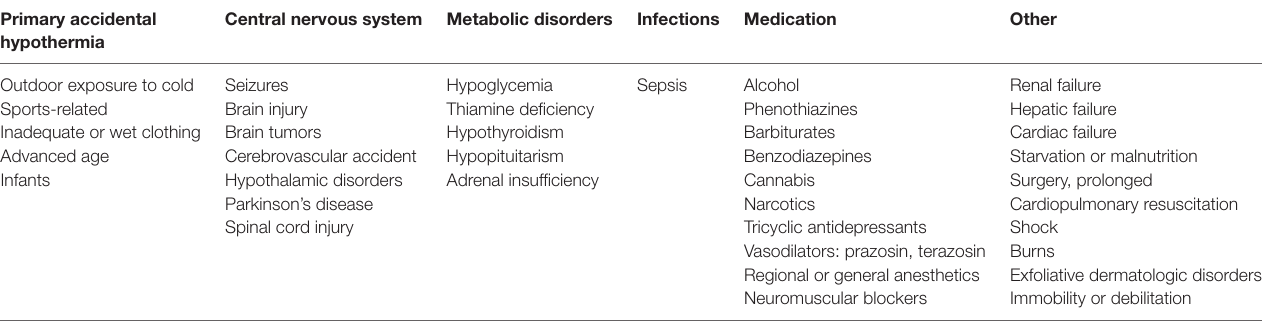
taBLe 2 | Predisposing factors for hypothermia, with examples per category [after Brevik and Farver